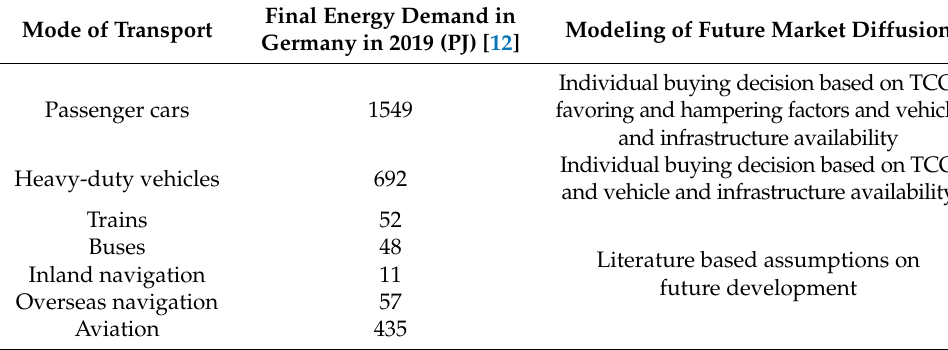
Table 1. Overview of transport modes, their final energy demand in Germany in 2019, and the modeling approach. Final Energy Demand in Modeling of Future Market Diffusion Mode of Transport Germany in 2019 (PJ) [12] Individual buying decision based on TCO, Passenger cars 1549 favoring and hampering factors and vehicle and infrastructure availability Individual buying decision based on TCO 692 and vehicle and infrastructure availability 52 Literature based assumptions on future